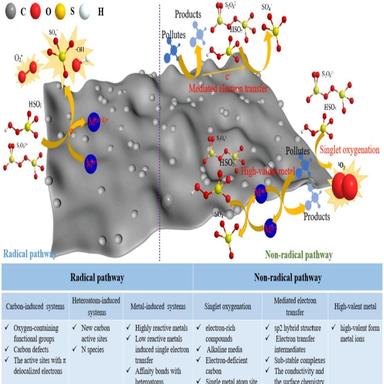
Possible mechanism of the radical and non-radical pathways activated by MOFs-derived CMs.